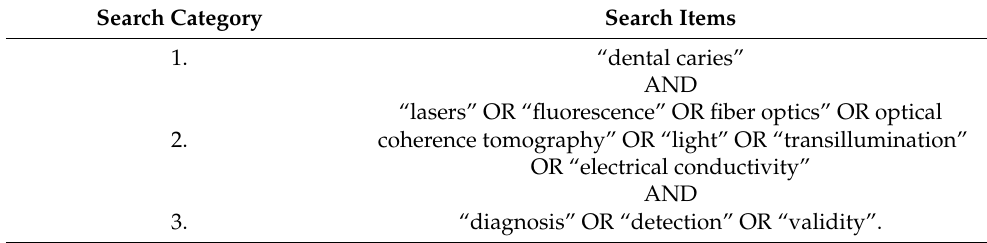
Table 1. Search strategy used to search PubMed, EMBASE, and